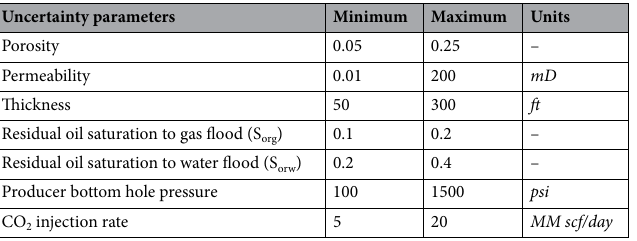
Table 1. The uncertainty variables for generation the reservoir simulation samples.